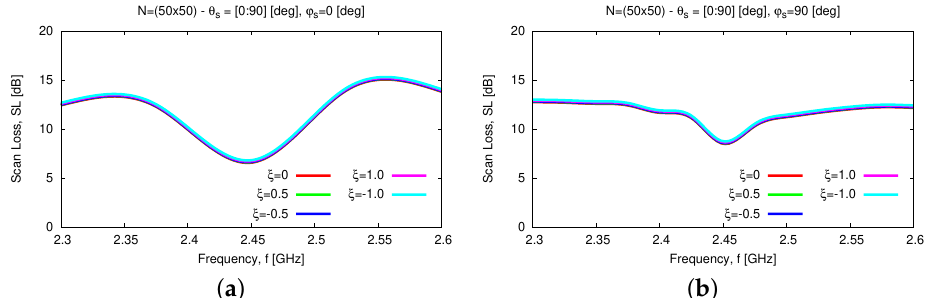
Figure 18. Numerical Assessment ( [ f min , f max ] = [ 2.3, 2.6 ] [GHz]— N = ( 50 × 50 ) )— SL performance versus frequency when steering the beam towards θ s ∈ [ 0, 90 ] [deg] and ( a ) ϕ s = 0 [deg] or ( b ) ϕ s = 90 [deg] for different settings of the manufacturing tolerance ξ on the feeding line ( W f ) and the parasitic ring ( W r )